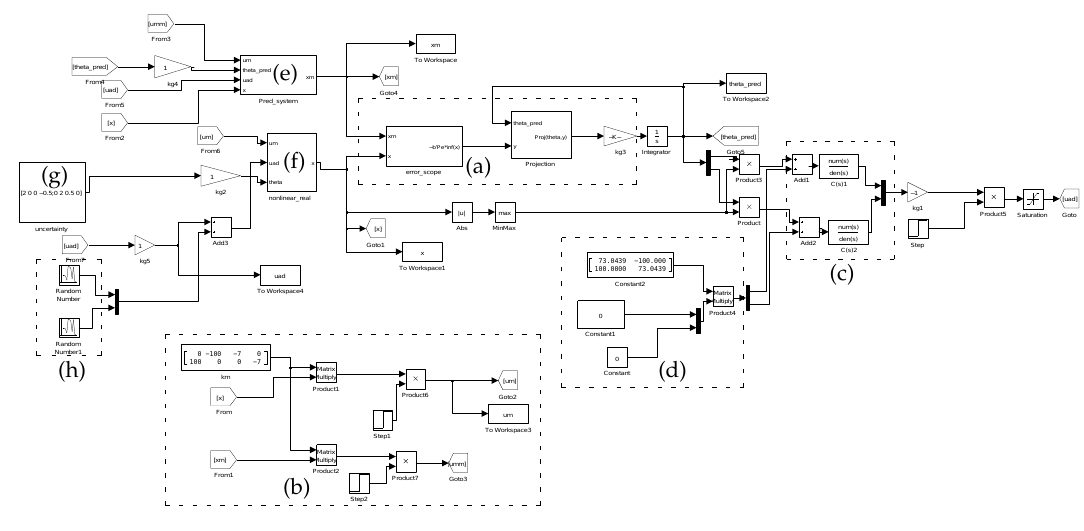
Figure 3. Block diagram in Simulink.